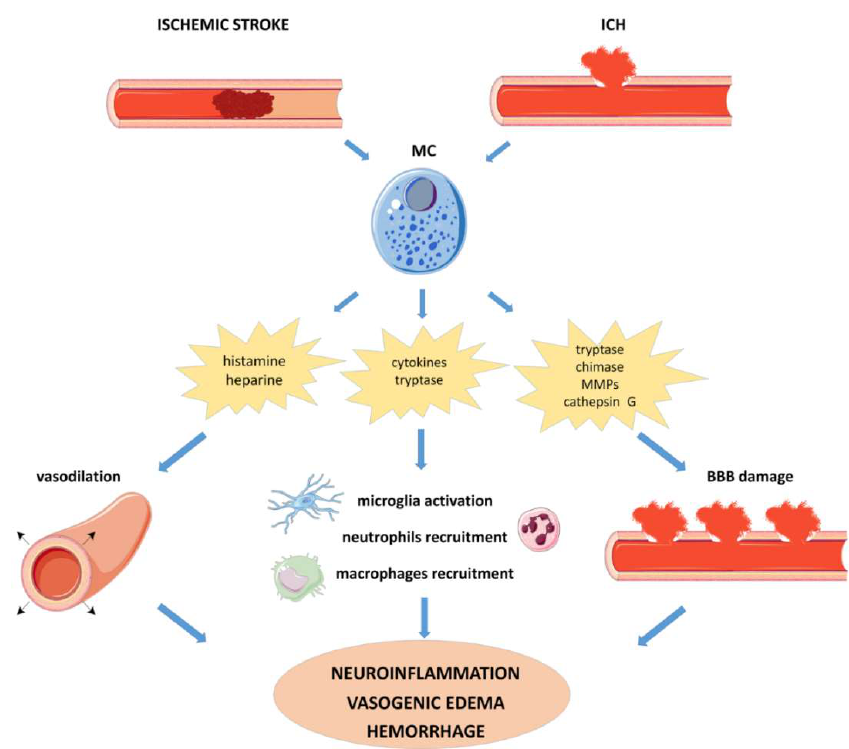
Figure 1. Schematic diagram showing the role of MCs in ischemic stroke and ICH. In the ischemic stroke, after cerebral blood vessel obstruction MCs sense alarm signals from injured parenchymal cells and become activated. In the ICH, the mastocytic activation is mediated by the leakage of blood products from the damaged vessel. Upon activation, MCs release a variety of vasoactive and proinflammatory molecules, including histamine, heparine, cytokines (TNF- α , ILs, chemokines), proteases (tryptase, chymase, MMPs, cathepsine G). The preformed and newly synthetized mediators induce vasodilatation, recruitment of peripheral immune cells toward the infarcted area, and BBB disruption, promoting a sustained neuroinflammation. In ischemic stroke, the pathological scenario supported by MCs activation has been involved in the hemorrhagic conversion mediated by rtPA treatment. In the ICH, the recruitment of inflammatory cells maintain and potentiate the initial BBB leakage, leading to an aggravation of hemorrhage and vasogenic edema. The mechanisms of MCs-mediated pathogenesis of stroke in the adult brain are valid also in the immature brain. BBB: blood–brain barrier; ICH: intracerebral hemorrhage; IL: interleukin; MCs: mast cells; MMP: metalloproteinase; rtPA: recombinant tissue plasminogen activator; TNF: tumor necrosis factor.